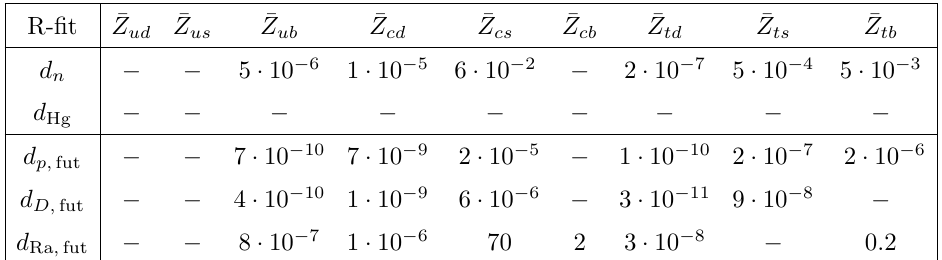
Table 9 . Limits on the S 1 di-quark couplings (cid:22) Z qq 0 (cid:17) m 2 matrix elements within their allowed ranges.